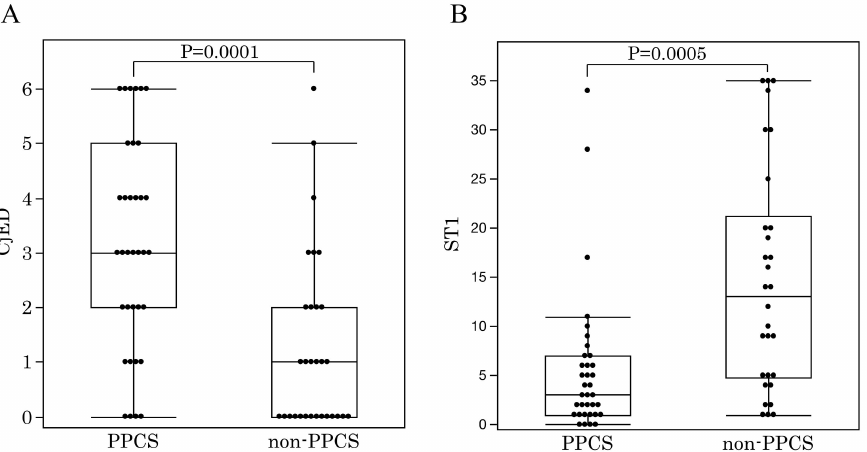
Figure 3. ( A ) Conjunctival epithelial damage (CjED) and ( B ) Schirmer I test (ST1) results in the patchy pattern corneal staining (PPCS) group and non-PPCS group. There was a statistically significant difference in both results between the two